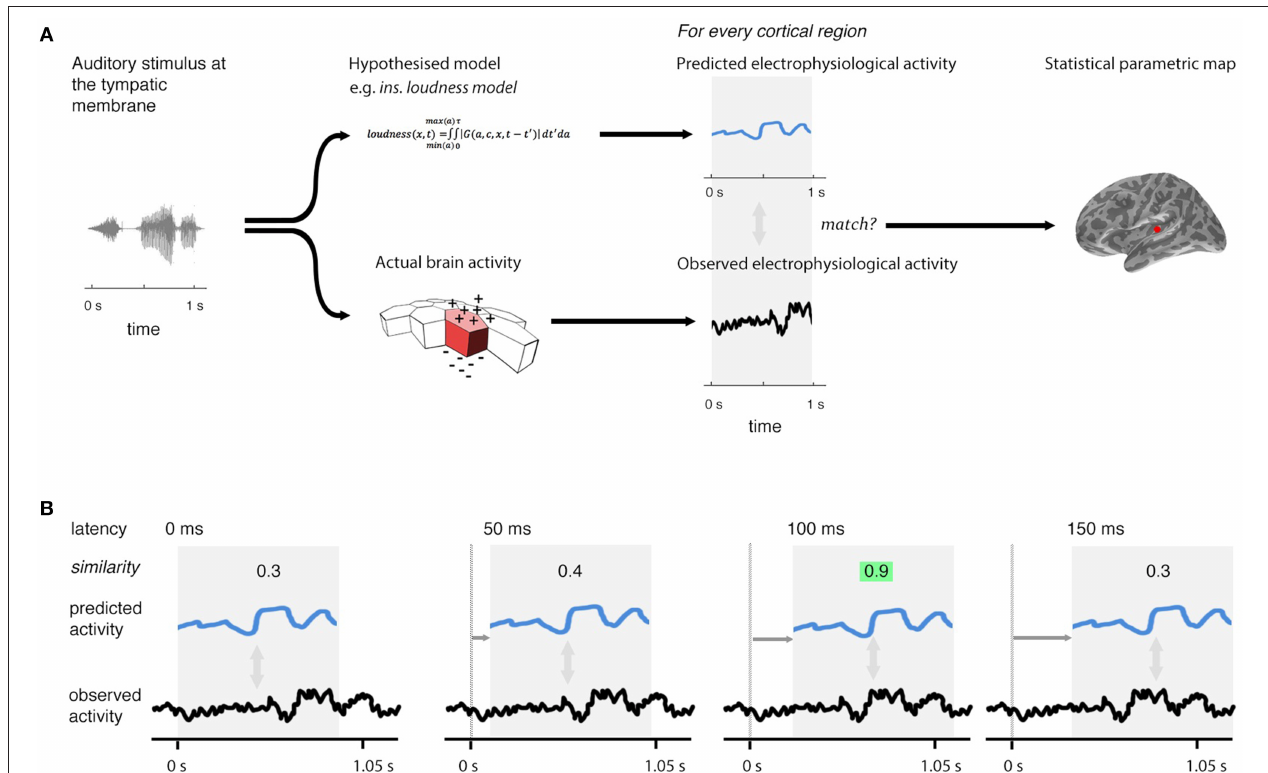
FIGURE 2 | Technique overview. First (A) , the electrophysiological activity of the brain in response to a given stimulus (measured using EMEG) is matched to the pattern of neural activity predicted by the model being evaluated. Predicted and observed activity are tested for similarity and the resulting statistical parametric map displays the regions (sources) where the match is statistically significant. Second (B) , this procedure is repeated at different lags (illustrated here from 0 to 150ms) between the onset of the observed neural activity and the onset of the predicted output. The similarity is highest at the correct lag (highlighted). This produces a statistical parametric map that changes over